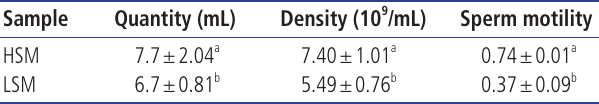
Table 4. The sperm samples with high and low motility main parameter comparison 1) Sample Quantity (mL)